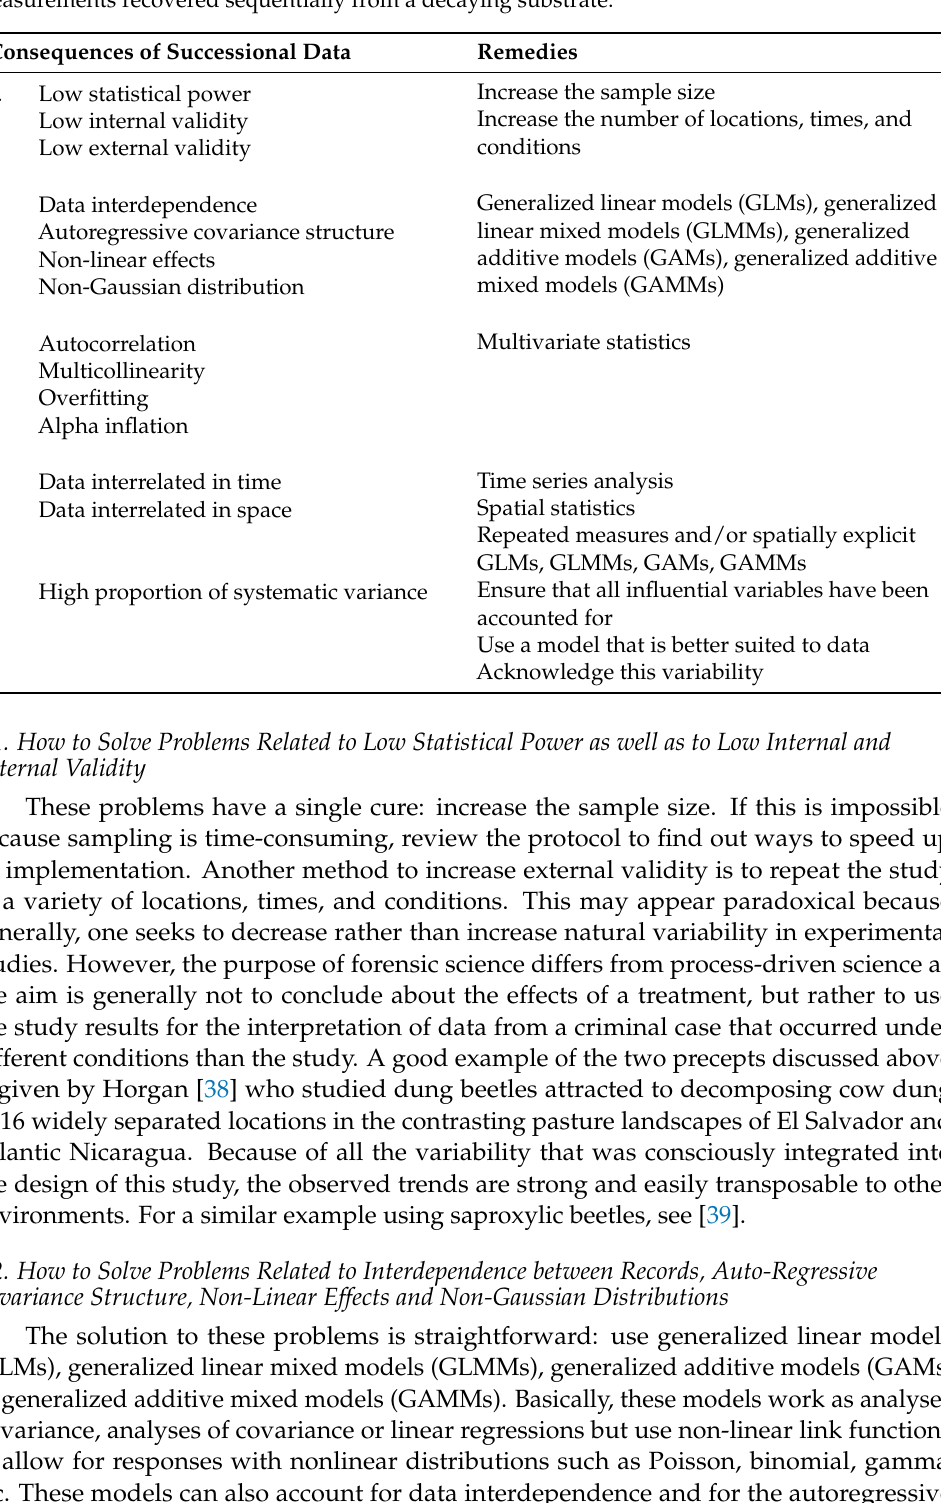
Table 2. Consequences and possible remedies to the issues associated with successional samples or measurements recovered sequentially from a decaying